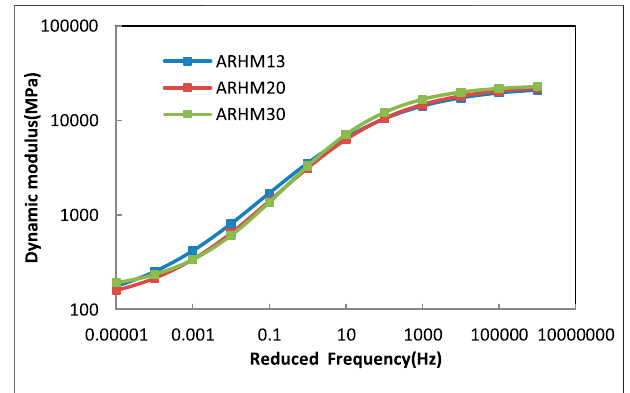
FIGURE 8 | Main curve of dynamic